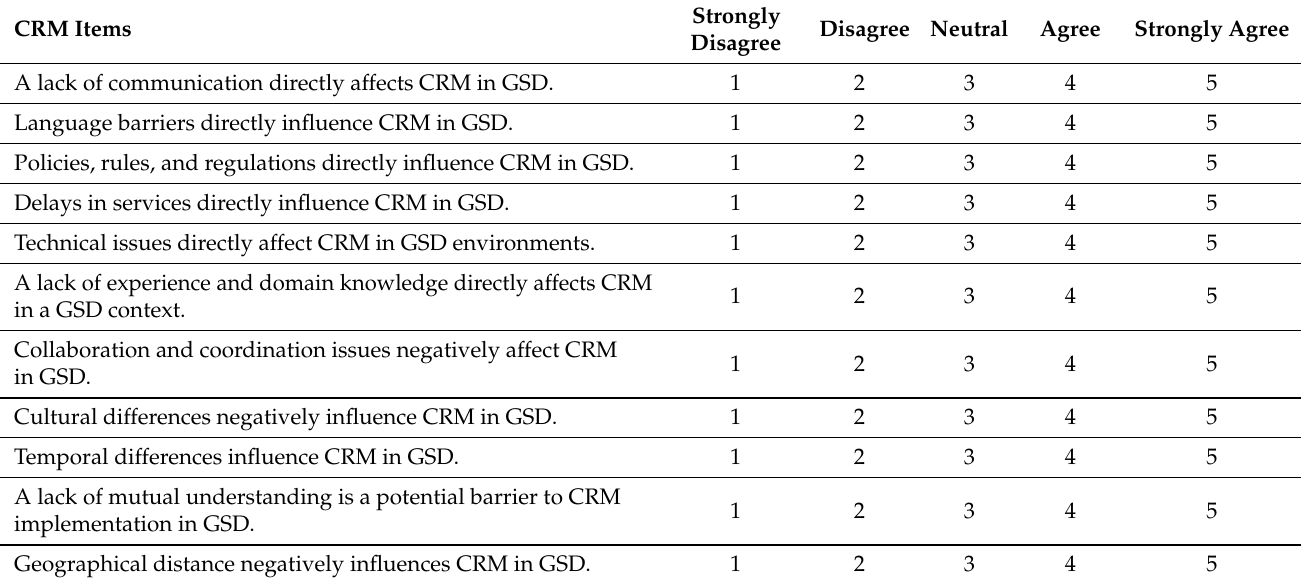
Table A3. Section D—CRM in GSD (construct related in